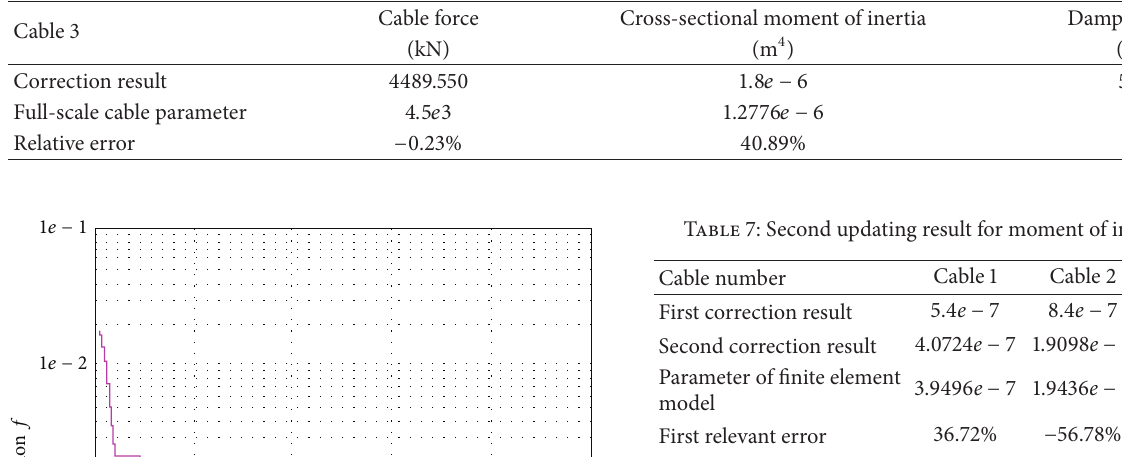
Table 6: Model updating results for simulated cable B17.